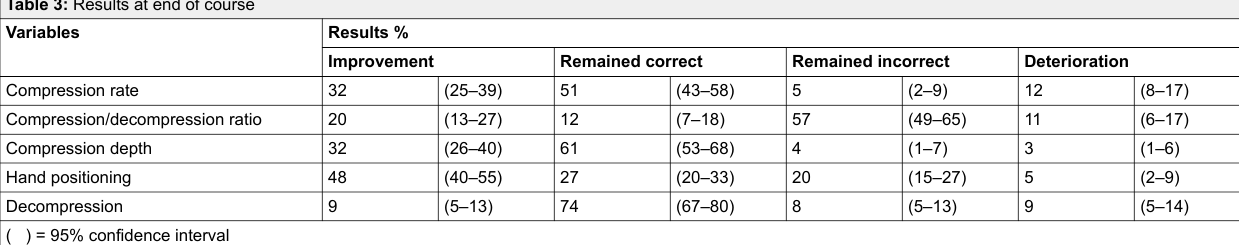
Table 3: Results at end of course